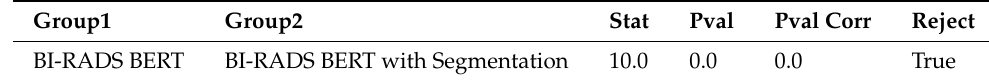
Table A25. McNemar test results for field extraction of purpose.